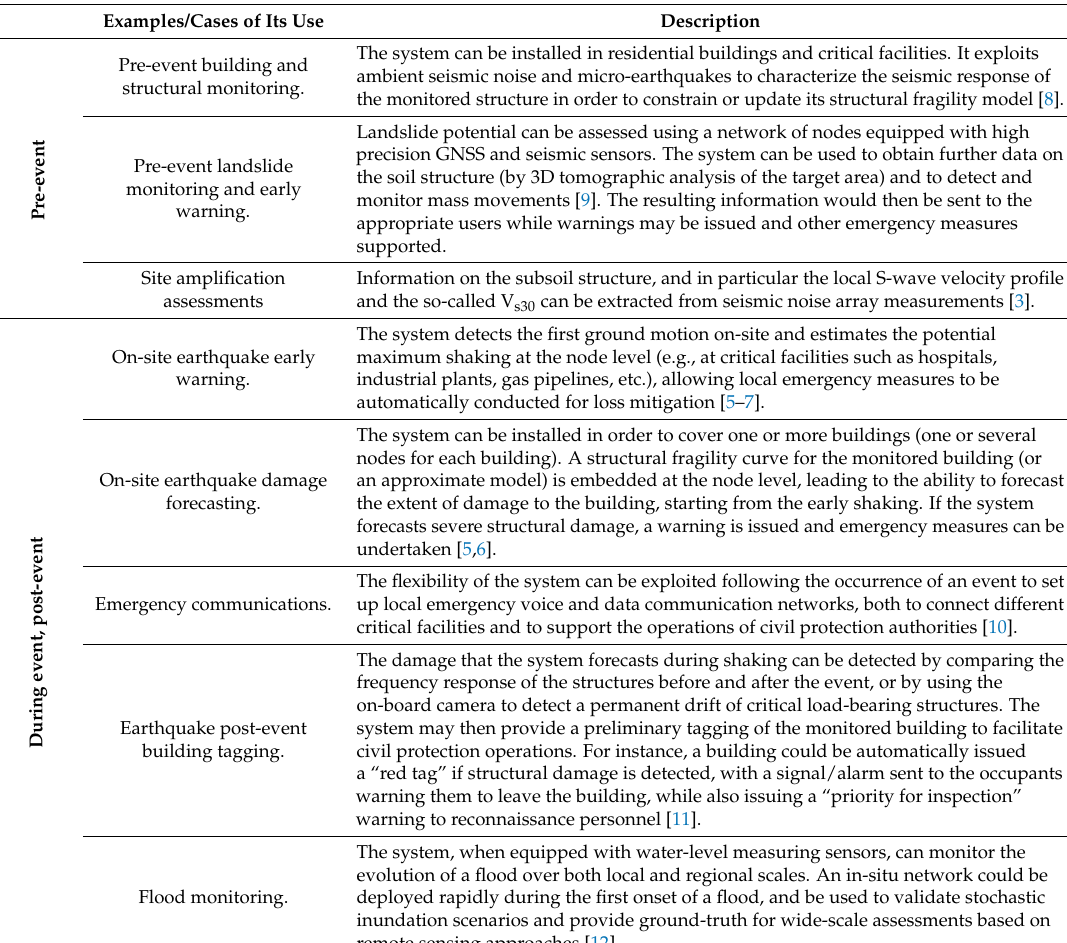
Table 1. Examples of how the MPwise system could be